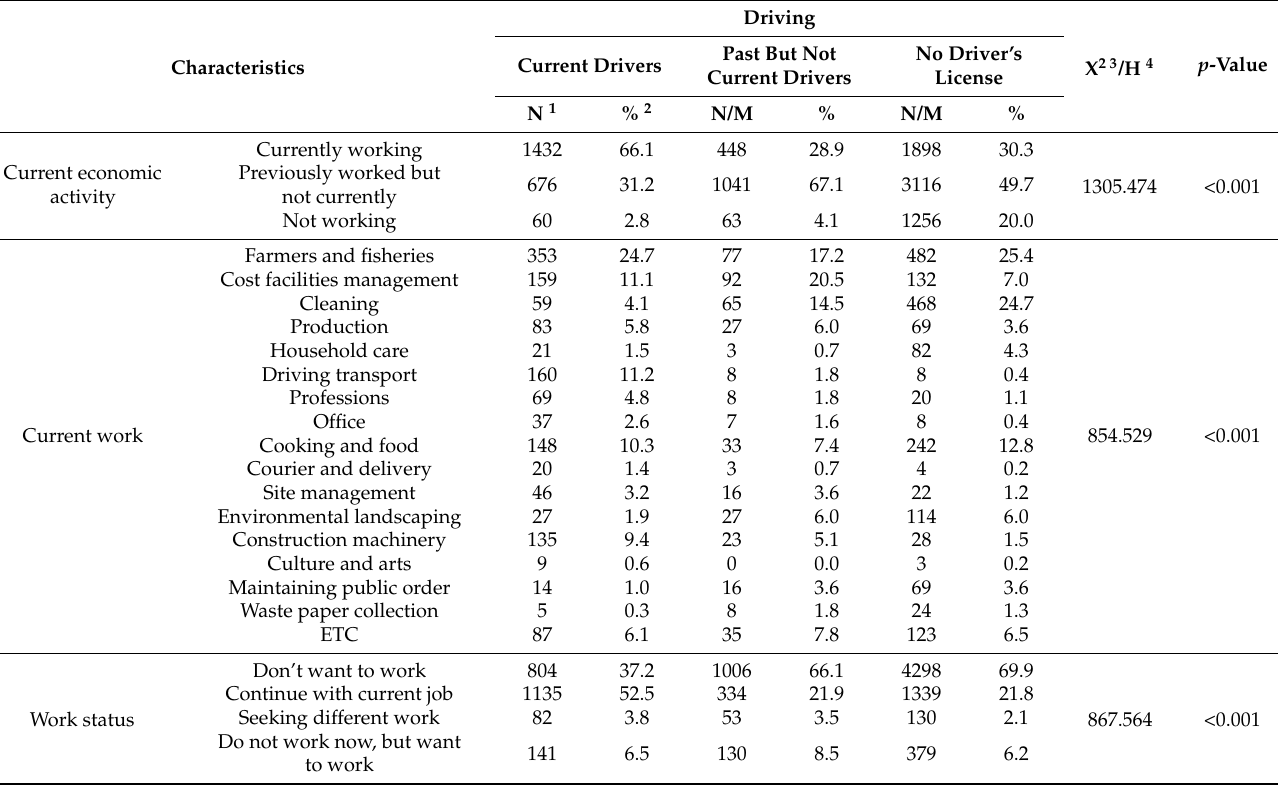
Table 4. Social and economic